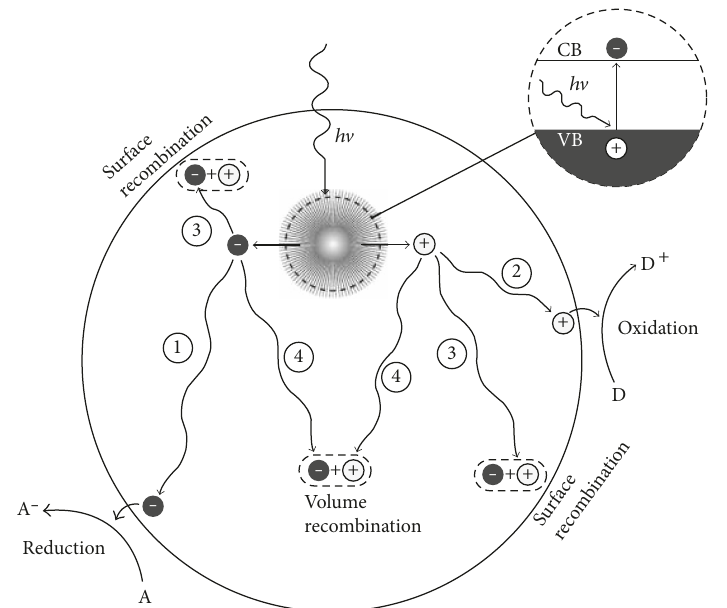
Figure 4: Schematic demonstration of the photocatalytic mechanism of TiO permission from [10]. Copyright (2013)